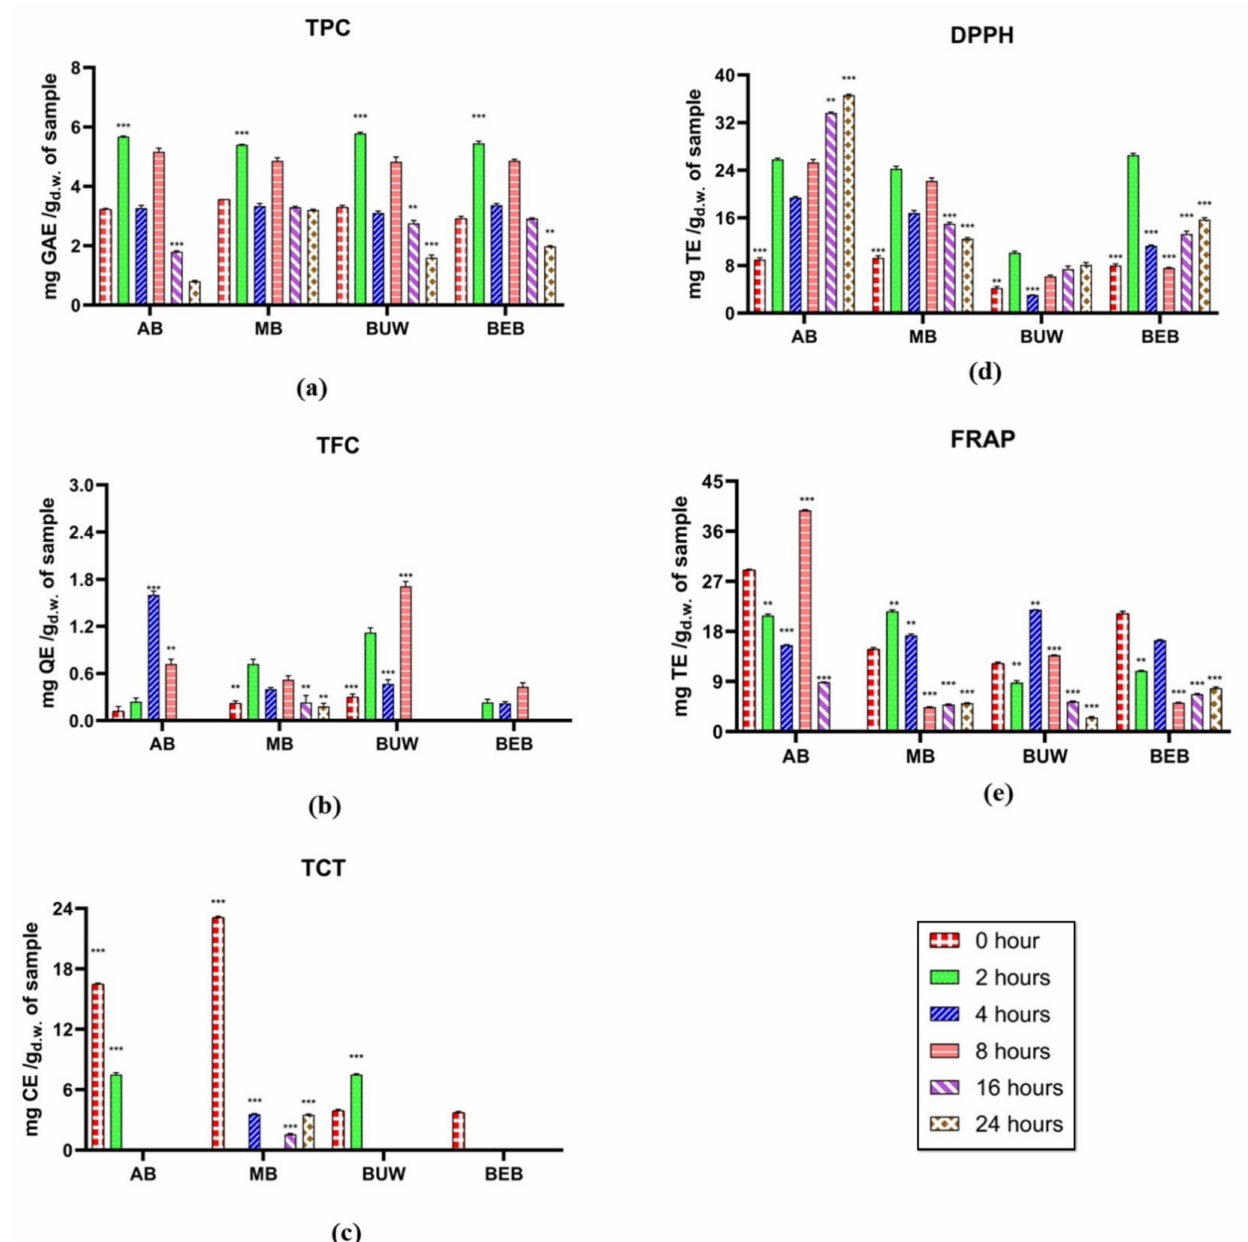
Figure 2. The antioxidant potential estimation of different legumes digesta after complete colonic fermentation. ( a ) Total phenolic content; ( b ) total flavonoids content; ( c ) total condensed tannins; ( d ) 2,2 (cid:48) -diphenyl-1-picrylhydrazyl antioxidant assay; ( e ) ferric reducing antioxidant power assay. The results of all assays were pure values which have been removed the values of control. Legume samples mentioned in abbreviations are Adzuki Beans “AB”; Mung Bean “MB”, Black Urid Whole “BUW”, Black Eye Beans “BEB”. Red bar: 0 h; Green bar: 2 h; Blue bar: 4 h; Pink bar: 8 h; Purple bar: 16 h. Brown bar: 24 h. GAE: gallic acid equivalents; QE: quercetin equivalents. TE: Trolox equivalents. **: Statistically significant different ( p ≤ 0.05); ***: Statistically very significant different ( p ≤